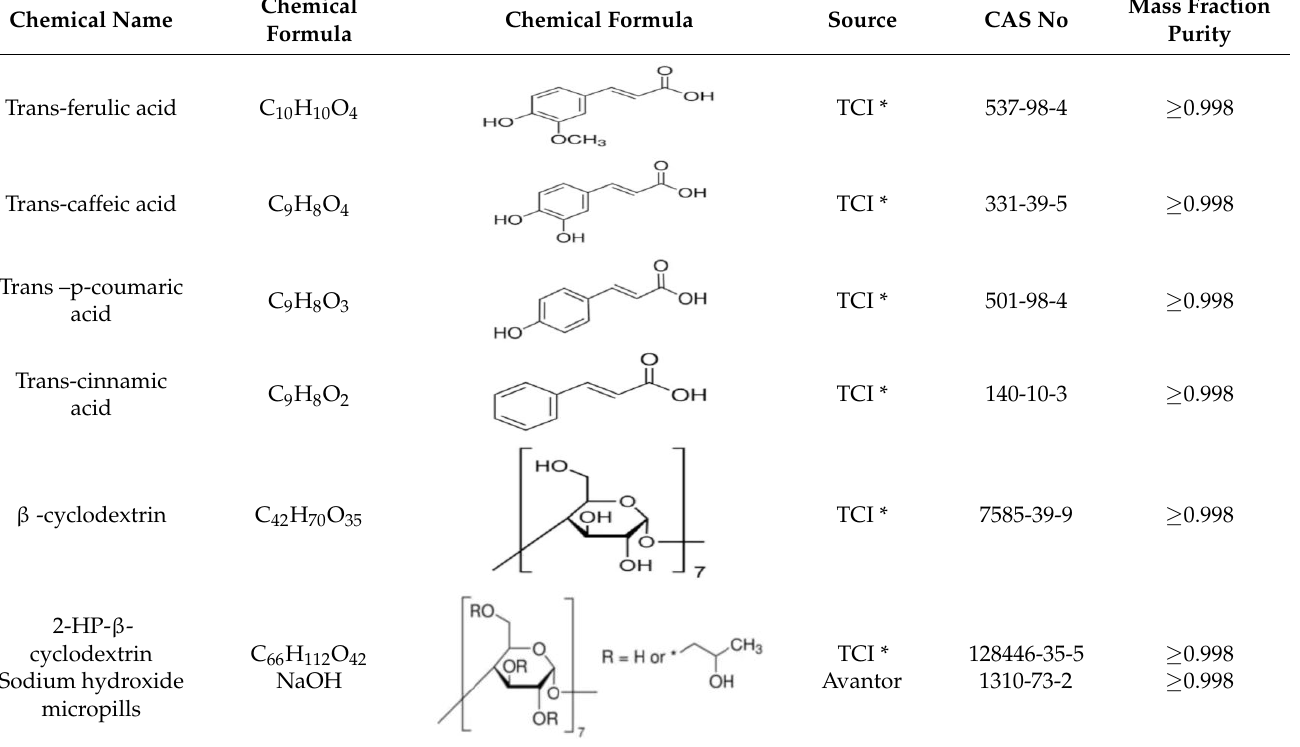
Table 9. Specification of chemical